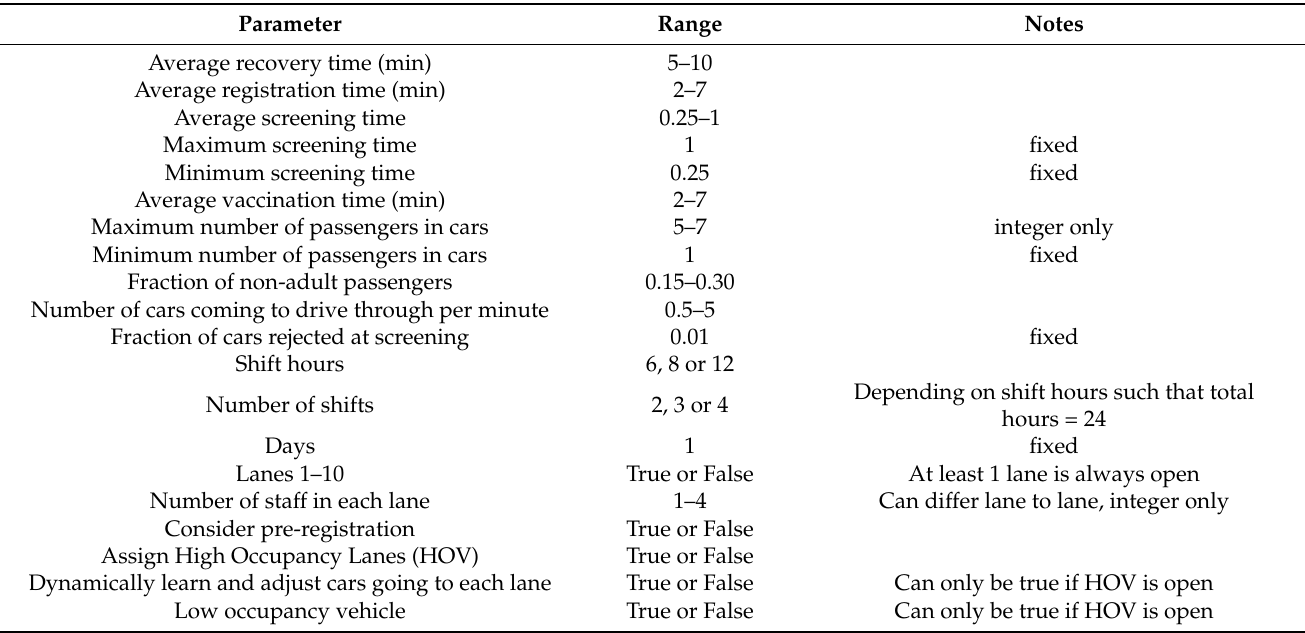
Table 2. Parameter sampling ranges for model